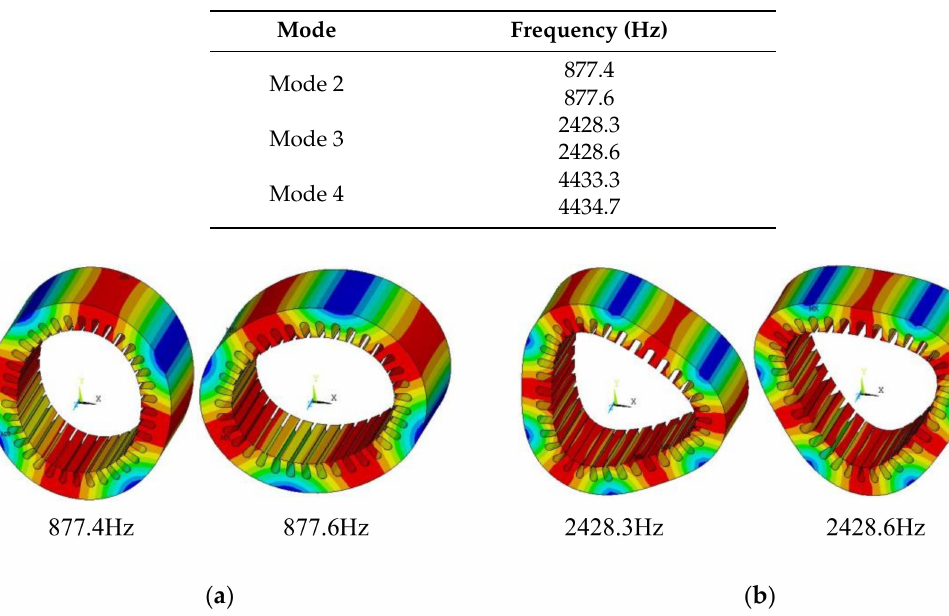
Table 4. Natural frequencies of the stator.